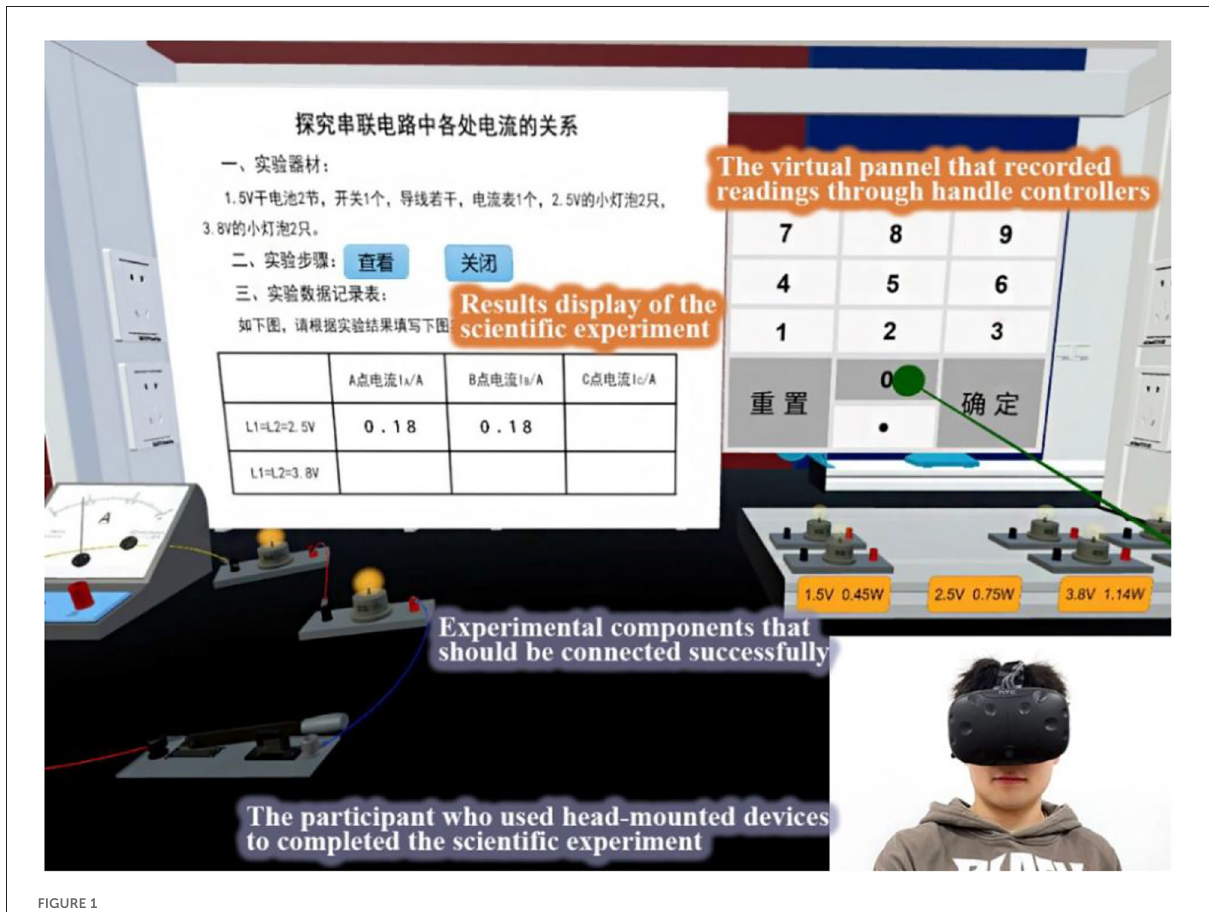
FIGURE1 The developed VaSE